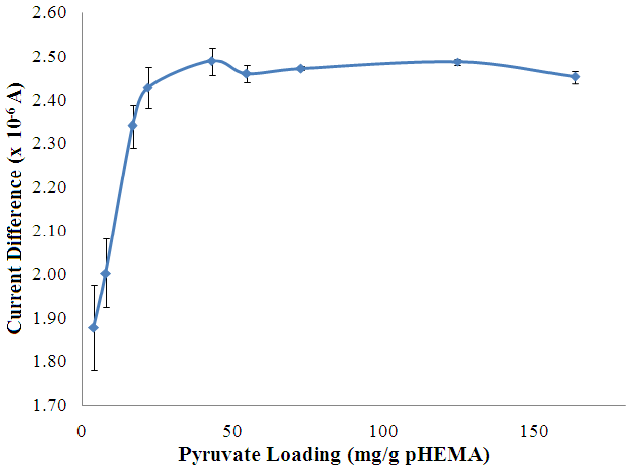
Figure 8. The effect of the amount of pyruvate entrapped in a pHEMA membrane on the